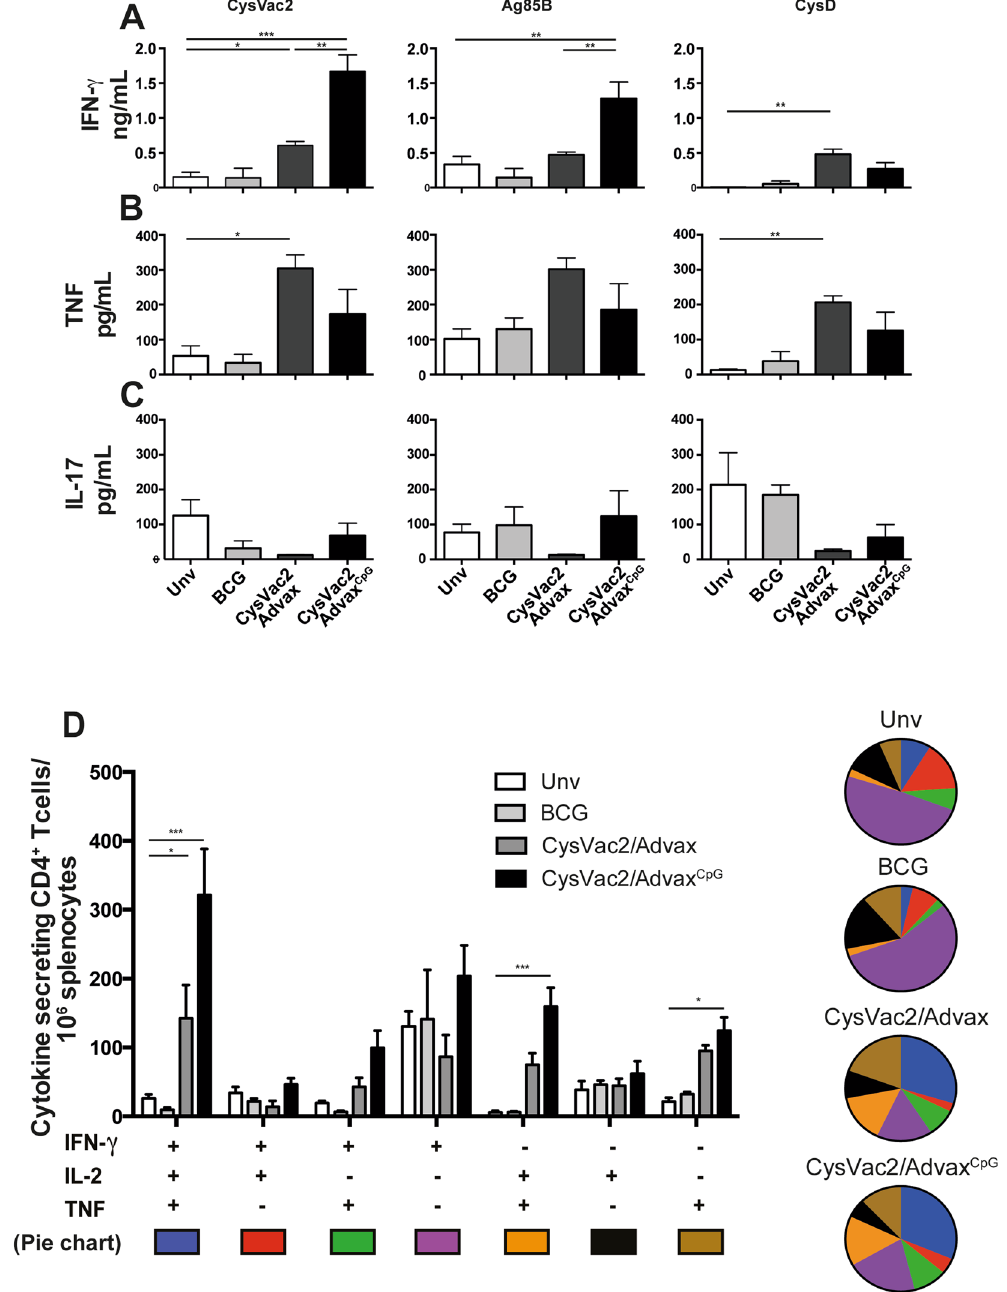
Figure 3. Vaccine-specific CD4 + T cell response post- M. tuberculosis challenge. C57BL/6 mice (n = 5) were vaccinated as in Fig. 2 and 12 weeks after the first vaccination mice were challenged with approximately 100 CFU of M. tuberculosis . Four weeks after infection splenocytes were re-stimulated with CysVac2 or its singular components (Ag85B and CysD) and the levels of IFN- γ ( A ), TNF ( C ) or IL-17 ( C) production in the supernatants were measured by ELISA. Splenocytes were re-stimulated in vitro with CysVac2 in the presence of brefeldin A and the frequency of CysVac2-specific cytokine secreting CD4 + T cells determined by flow cytometry ( D ). Data (average ± SEM) is representative of two independent experiments. Statistical significance between the groups was determined by ANOVA ( * P < 0.05, ** p < 0.01; ** p <